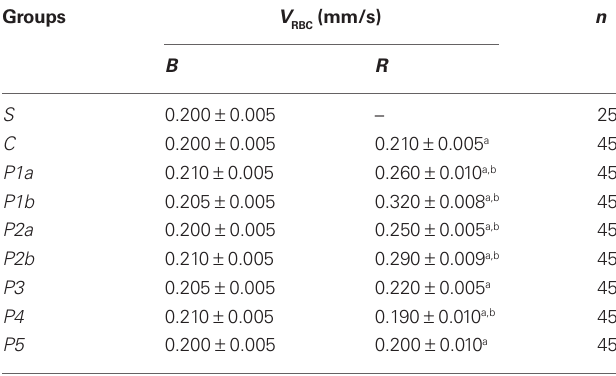
Table 1 | Capillary red blood cell velocity ( V conditions ( B ) and after reperfusion ( R ) in all experimental